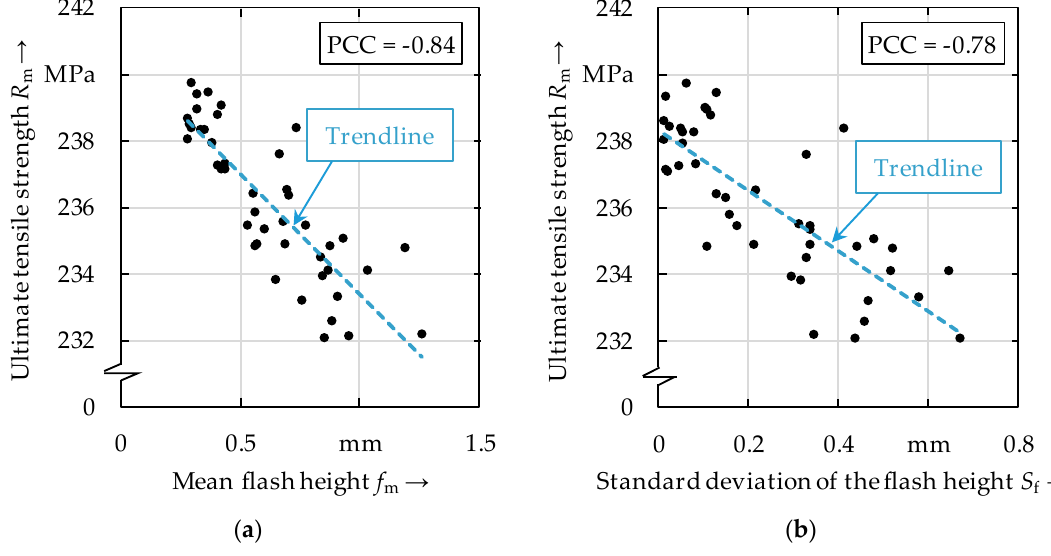
Figure 4. Ultimate tensile strength R m ( a ) as a function of the mean flash height f m and ( b ) as a function of the standard deviation of the flash height S f at a welding speed v s of 500 mm/min.